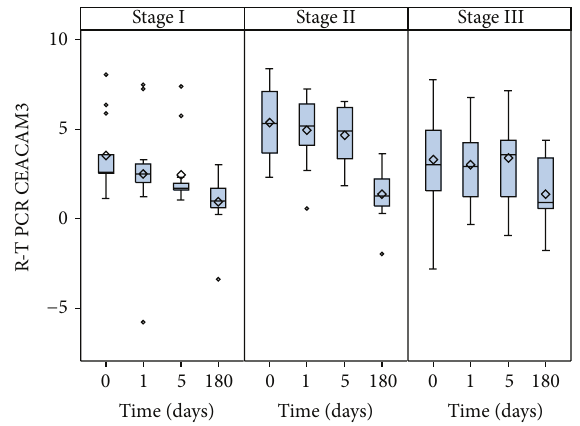
Figure 3: Decreasing trend of CEACAM3 from perioperative to early and late postoperative blood samples according to pathological stage